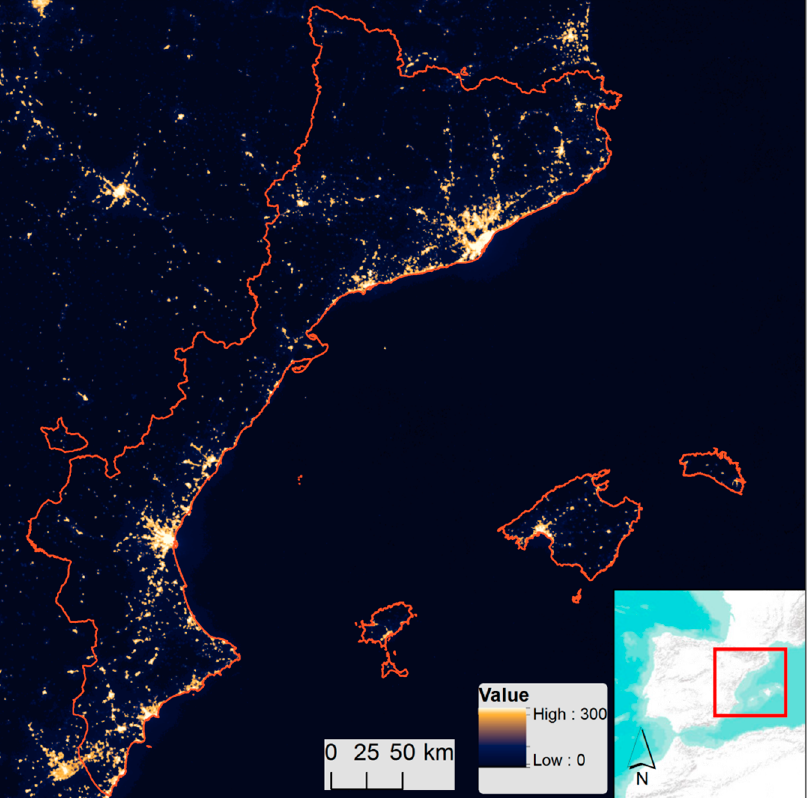
Figure 2. VIIRS/DNB image April 2012, study area.